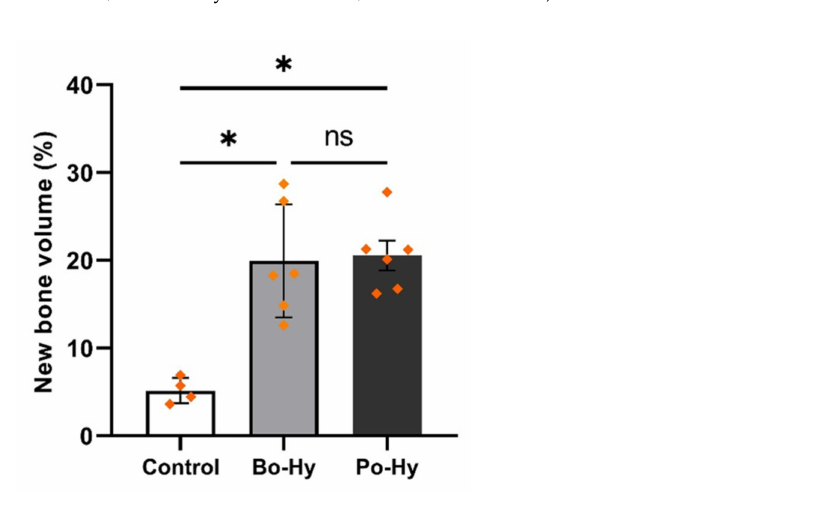
Figure 10. Reconstructed three-dimensional (3D) images within the 6 mm region of interest using micro-CT analysis after 8 weeks of healing. ( a ) Control, ( b ) Bo-Hy, and ( c ) Po-Hy (yellow: xenograft materials, red: newly formed bone, scale bars = 6 mm).